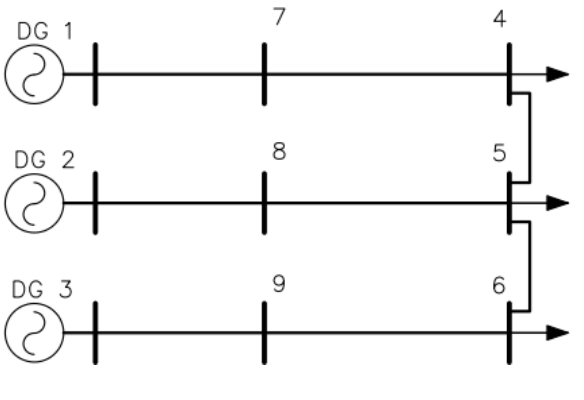
Figure 3. 9-bus test microgrid system. Table 1. Electrical features of the test microgrid